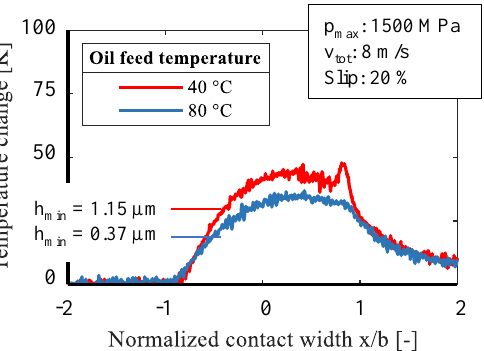
Figure 11. Influence of oil feed temperature on temperature change at 20% slip.